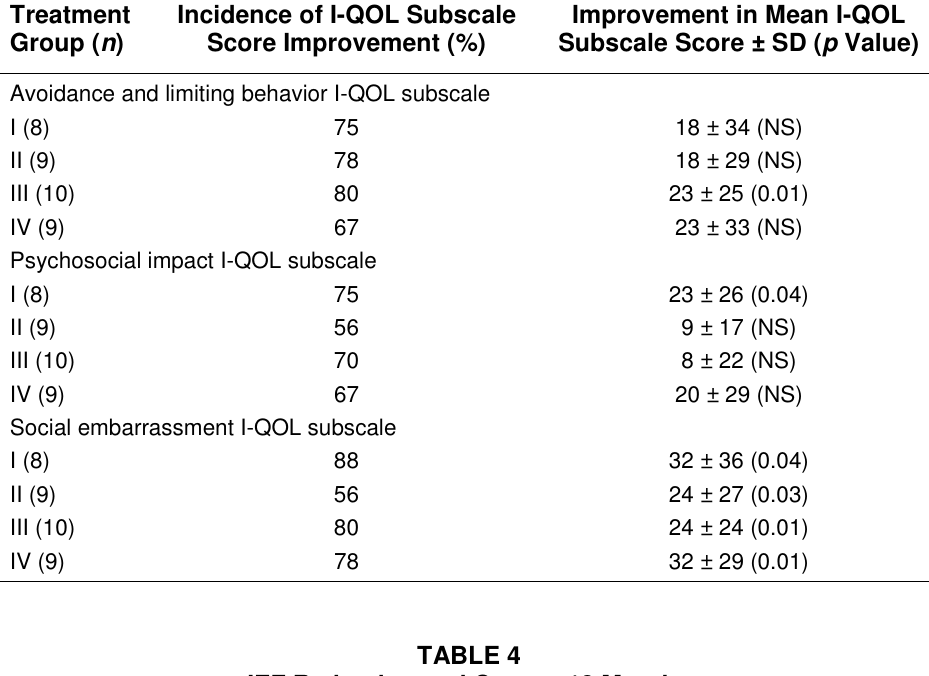
Improvement at 12 Months in Three I-QOL Subscale Scores vs.